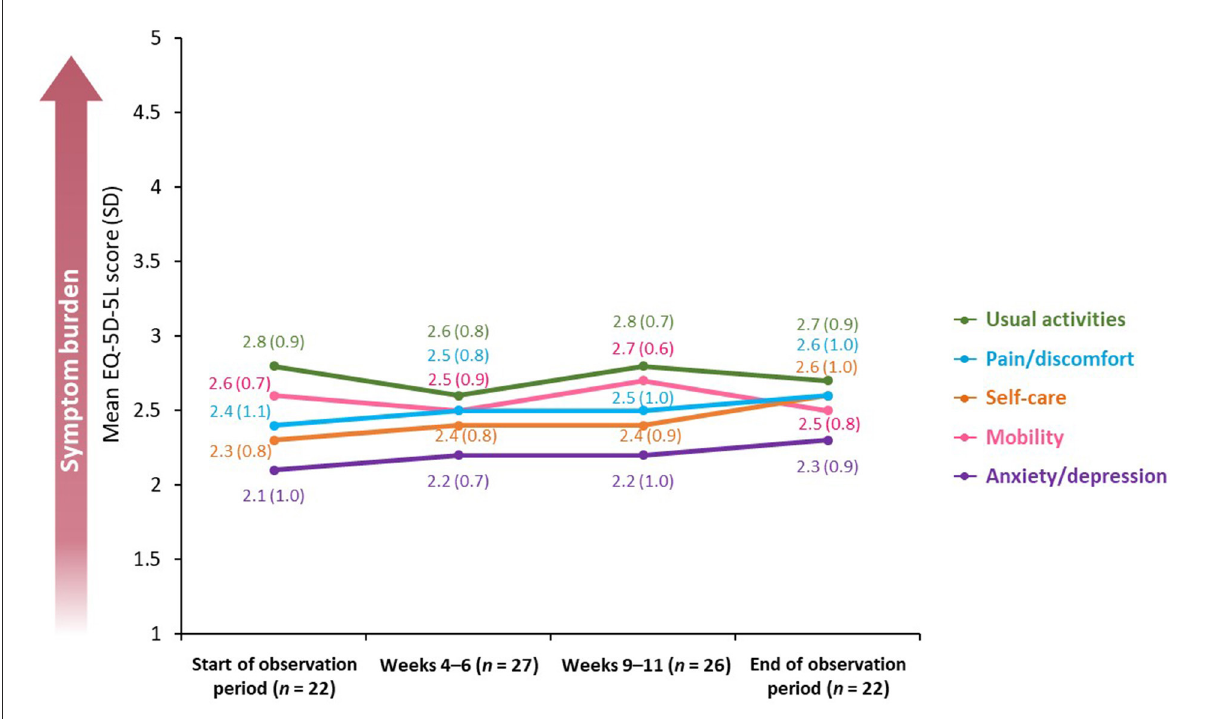
FIGURE5 Mean EQ-5D-5L score across a BoNT-A treatment cycle. BoNT-A, botulinum neurotoxin A; EQ-5D-5L, 5-level, 5-dimension EuroQol questionnaire; SD, standard deviation.